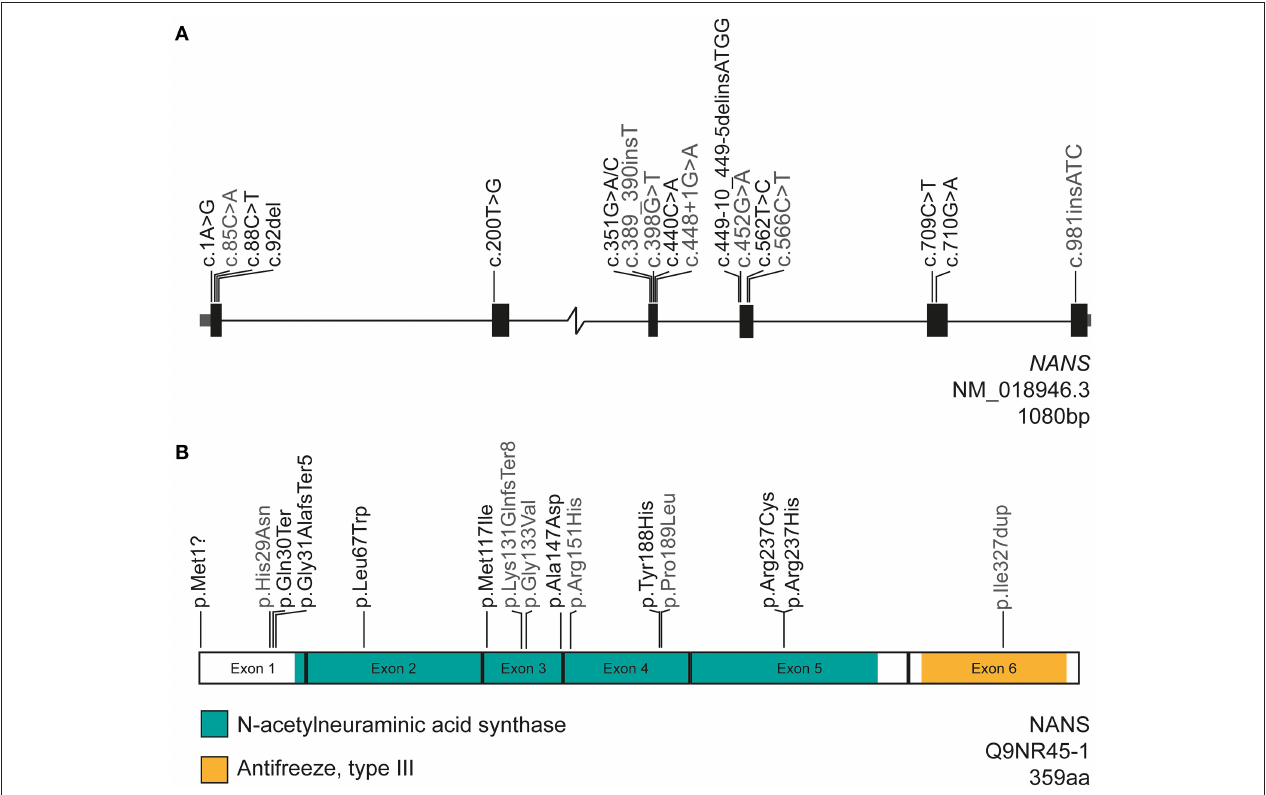
FIGURE 1 | Gene and protein structure of NANS encoding NANS. The nature and position of the variants reported in this study (black) and the previous case study (gray) are indicated ( 5). (A) NANS is 1,080 bp in length and consists of six exons. In total, 17 variants associated with NANS-CDG are reported in both studies combined, of which 10 are newly described in this case study. (B) The NANS protein is 359 amino acids in length and contains two domains: the N-term, the N -acetylneuraminic acid synthase domain (green) and the C-term antifreeze, type III domain (orange). The majority of variants are located in a domain from which 10 are located in the N -acetylneuraminic acid synthase